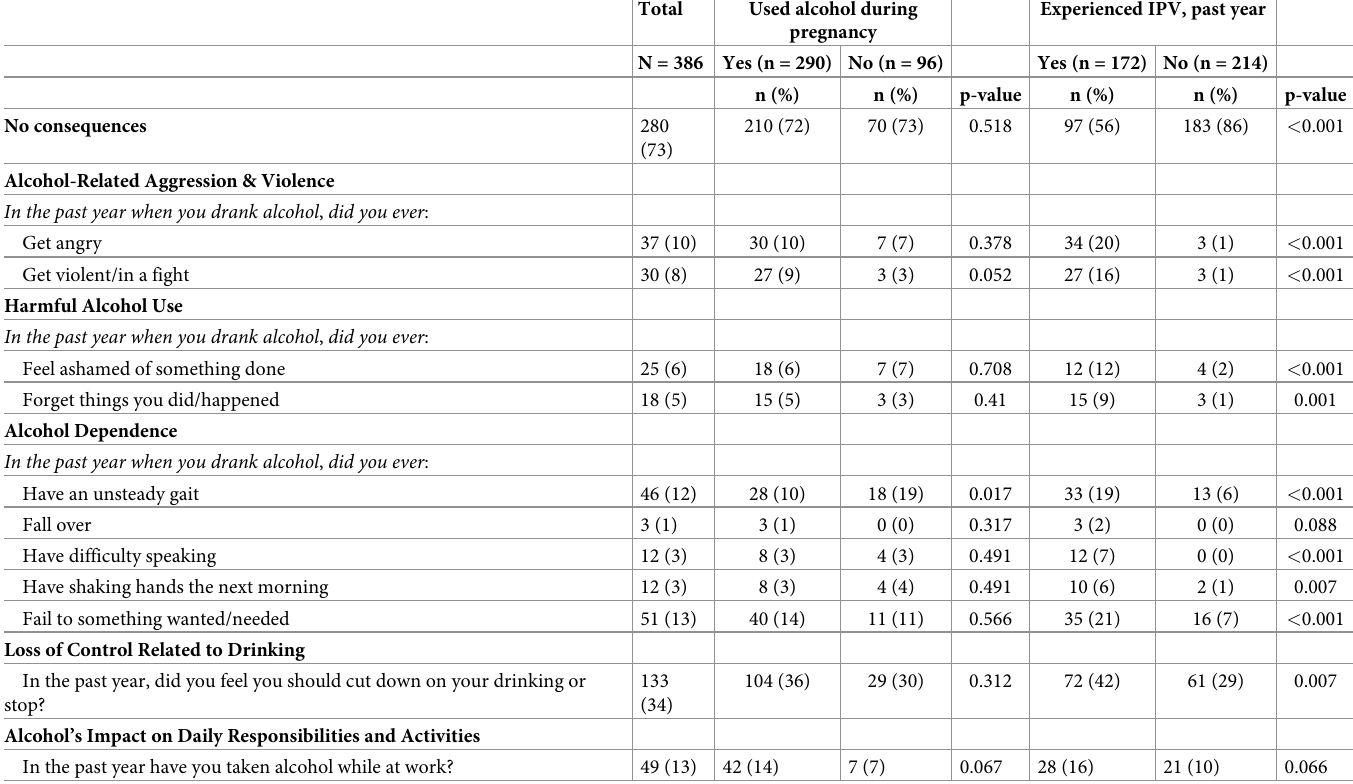
Table 3. Consequences of alcohol use among RCCS participants between March 2017 and September 2018 who reported to be pregnant and used alcohol in the past year, by alcohol use during pregnancy and